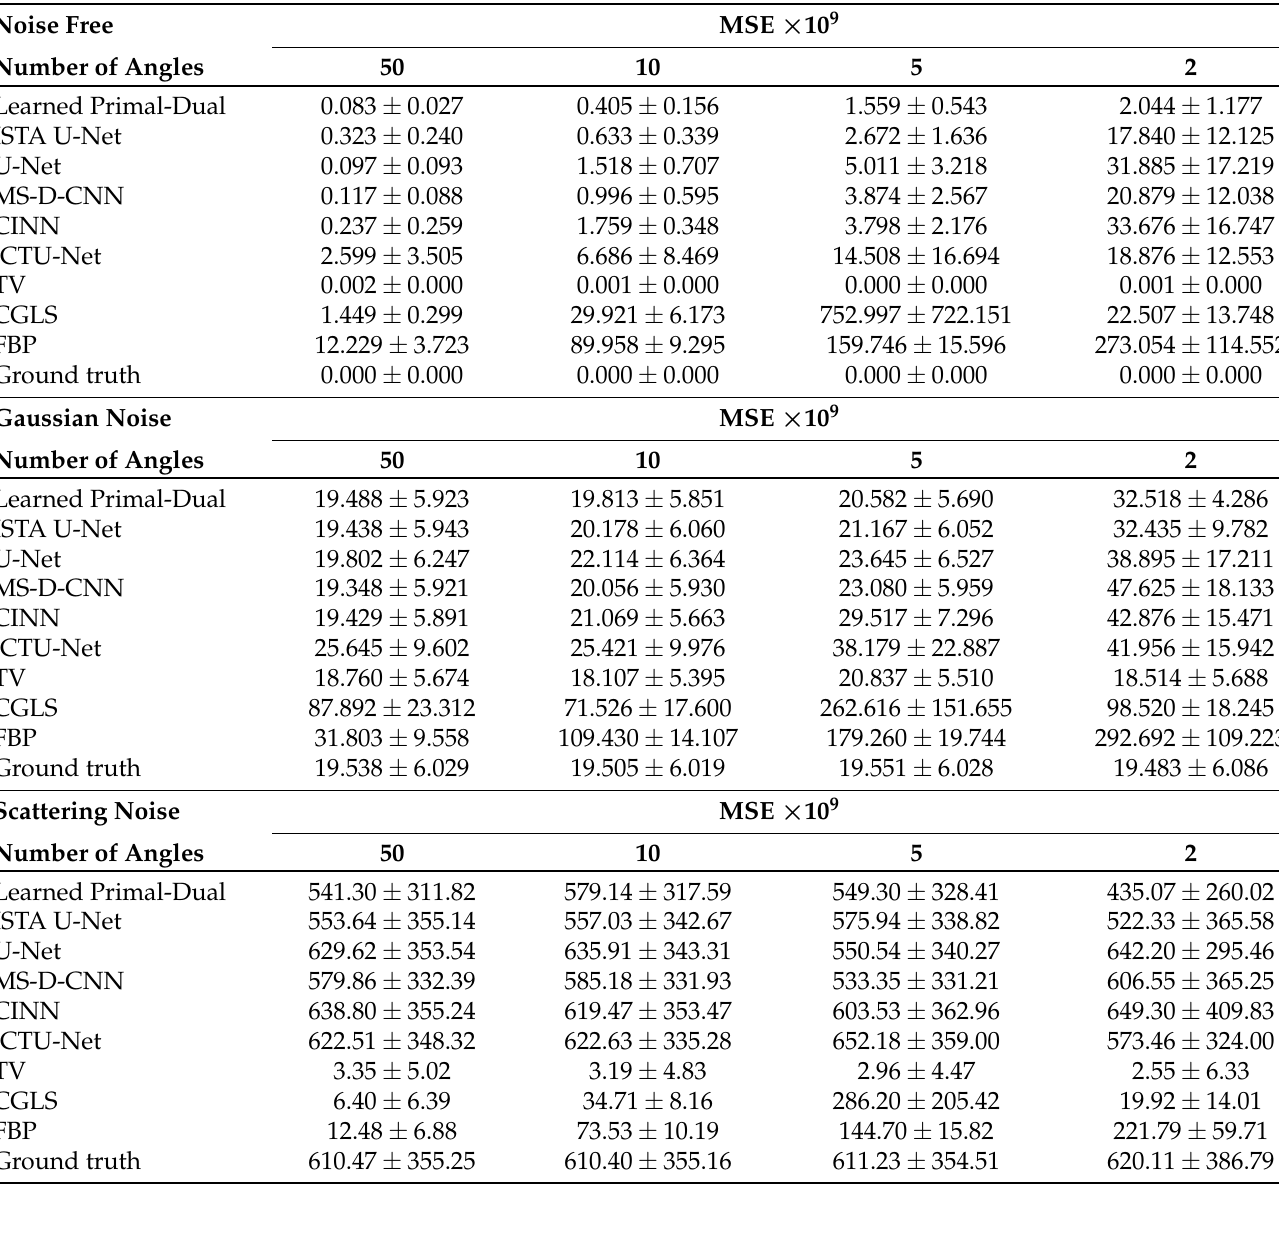
Table A6. Mean and standard deviation of the mean squared difference between the noisy measurements and the forward- projected reconstructions, respectively the noise-free measurements, on the 100 selected Apple CT test images.